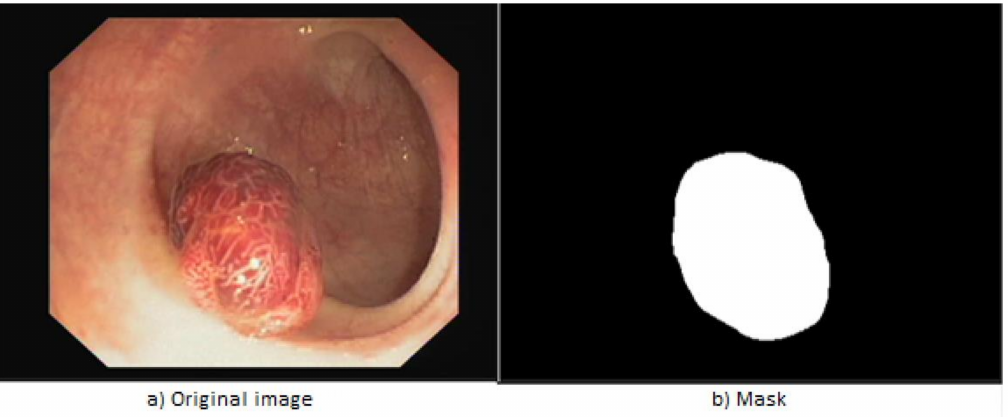
Figure 2. Example extracted from “CVC-ClinicDB”